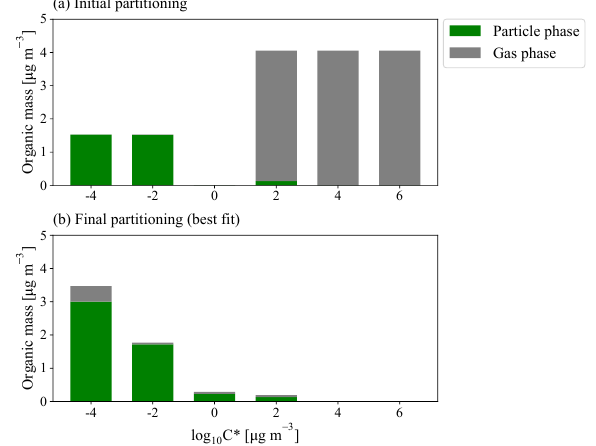
Figure 2. Example model (a) initial ambient and (b) final mod- eled partitioning for a 0.23 eq. day aging exposure from the BEACHON-RoMBAS campaign, with the particle-phase loadings in green and gas-phase loadings in grey (all in µgm − 3 ). The ini- tial S/IVOC concentration is evenly divided between the C ∗ = 10 2 and C ∗ = 10 6 µgm − 3 bins; the initial total aerosol mass is evenly divided between the C ∗ = 10 − 4 and C ∗ = 10 − 2 µgm − 3 bins. The C ∗ = 10 0 µgm − 3 bin is assumed to have an initial concentration of 0µgm − 3 . The input VOCs (MT for BEACHON-RoMBAS and MT and isoprene for GoAmazon2014/5) are assumed to be in a volatility bin greater than the C ∗ = 10 6 µgm − 3 bin (not shown). Panel (b) is the best-fit modeled final partitioning for this exposure, correspond- ing to 2 × k NUC1 , 5 × k OH , 0 . 5 × γ OH , k ELVOC , and α EFF = 0 . 01. The C ∗ = 10 − 4 µgm − 3 bin (assumed to represent ELVOCs) shows a significant amount of material remaining in the gas phase at the end of the modeled exposure, indicating that the production of gas- phase ELVOCs exceeded the timescale of condensation and gas- phase fragmentation within the